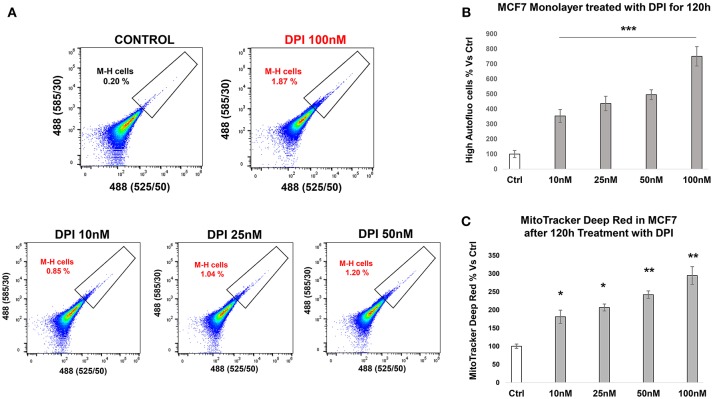
e-CSCs (2D) propagate in response to DPI, an OXPHOS inhibitor. (A) Representative tracings from flow-cytometry, monitoring the increase in the M-H cell sub-population. (B) The bar graph shows that the percentage of M-H cells are increased after treatment with DPI, a mitochondrial OXPHOS inhibitor, over a 5-days period, in a concentration dependent manner. (C) The bar graph shows that the mitochondrial mass (MitoTracker) is increased after treatment with DPI, over the same time-frame. *p < 0.01, **p < 0.001 and ***p < 0.0001.